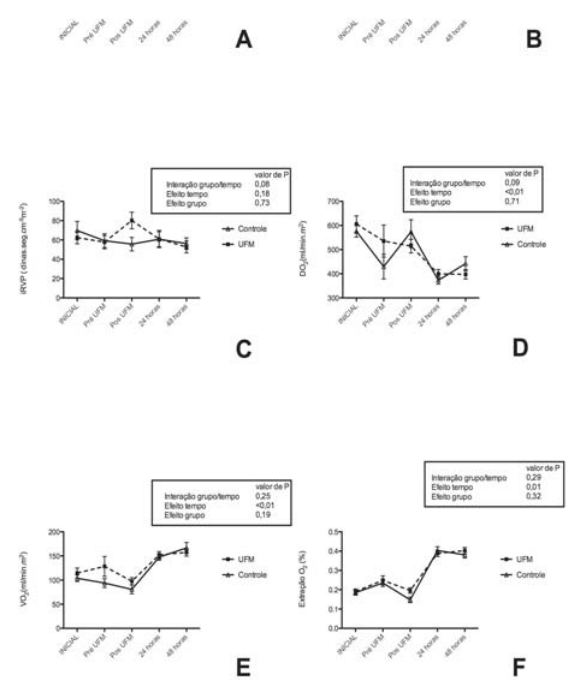
Fig. 2 - Variáveis hemodinâmicas e de transporte de oxigênio. Análise de variância com dois fatores para medidas repetidas. Valores expressos em média e dois erros padrão da média. (A) IC - índice cardíaco, (B) iRVS - índice de resistência vascular sistêmica, (C) iRVP - índice de resistência vascular pulmonar, (D) DO